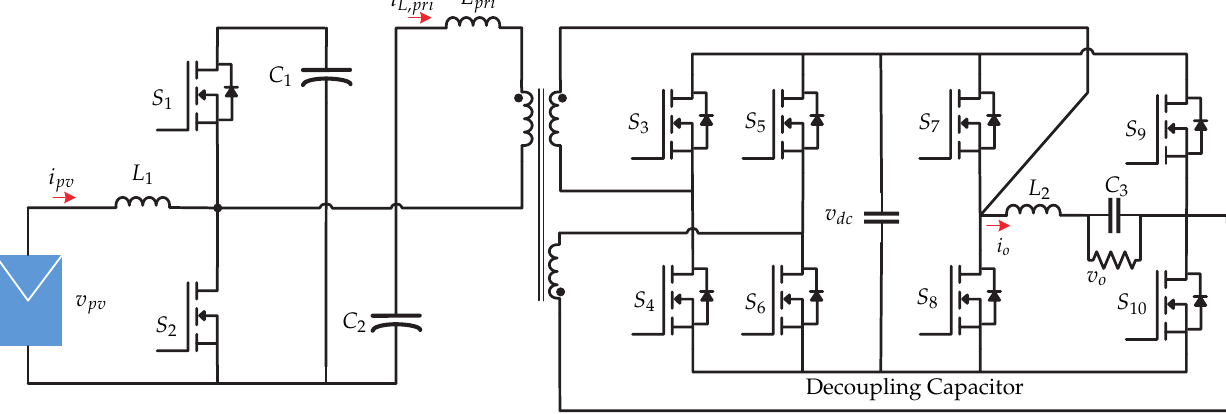
Figure 22. Microinverter’s topology proposed in [62].